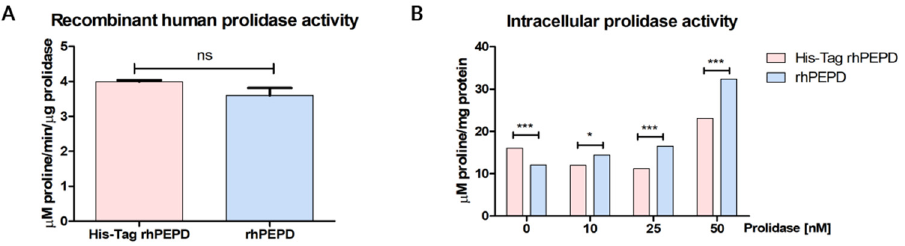
Figure 5. ( A ) The comparison of catalytic capabilities of His-Tag rhPEPD and rhPEPD. ( B )The effects of extracellular His-Tag rhPEPD and rhPEPD on intracellular prolidase activity in HaCaT cells. Statistical significances were expressed using asterisks such as * < 0.05, and *** < 0.001; ns - not